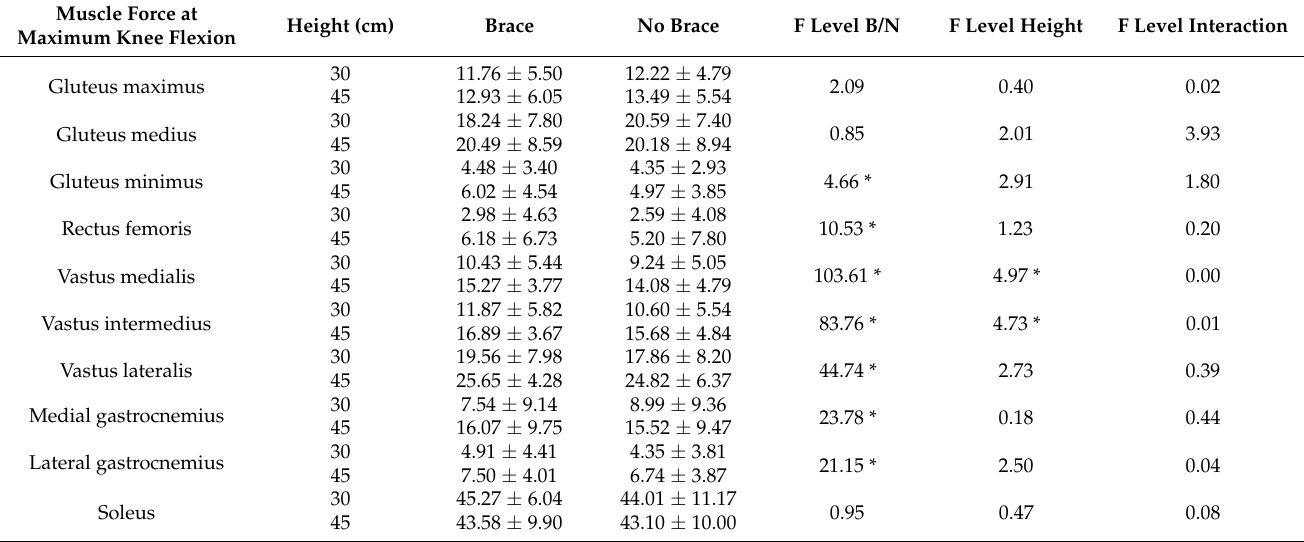
Table 2. Muscle force data (N/kg) during landing of the braced and non-braced participants at maximum knee